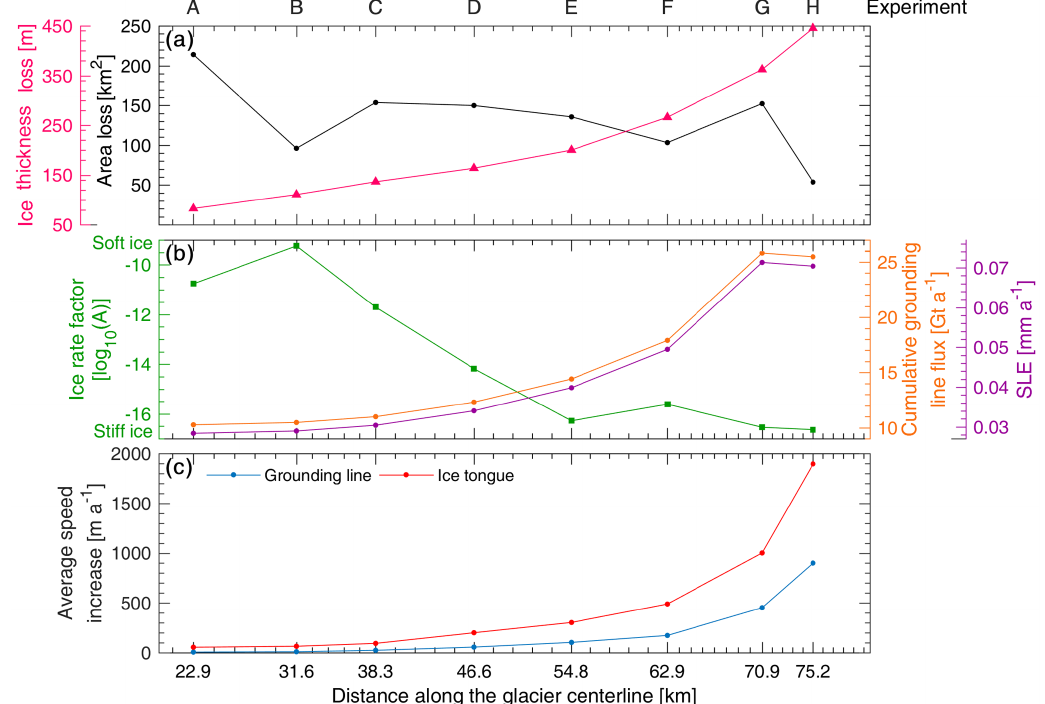
Figure 7. Modeled experiment parameters for Petermann Glacier, for each diagnostic experiment (A–H), also shown in Fig. 6. (a) The black line shows iceberg area lost between each experiment (km 2 ) and magenta is the average ice thickness (m) of each section of ice removed. (b) Green is the average ice rate factor (log 10 A ) across the section of ice removed in each diagnostic experiment. Orange and purple lines represent the cumulative grounding line flux with respect to an initial ice flux of 10.12Gta − 1 and sea level equivalent contribution after the removal of each section of ice. (c) Average increases in ice speed across the entire ice tongue (red) and average ice speed within 10km inland of the grounding line (blue) after each diagnostic